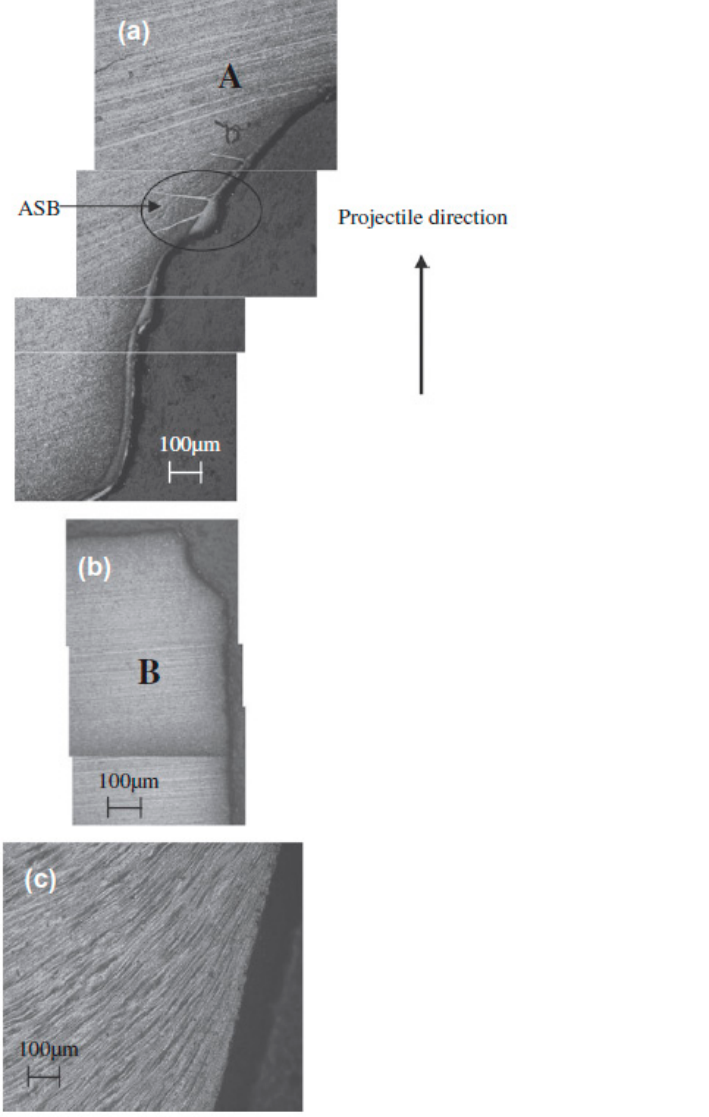
Figure 13. Micrograph of through thickness region of (PHHS + Al-alloy; PHHS-Perforated High Hardness Steel) configuration having 6 mm square holes ( a ) side A of front PHHS plate, ( b ) side B of front PHHS plate and ( c ) backing Al-alloy plate. The arrow shows the direction of the projectile. [47]. Reprinted with permission from Elsevier: Mater. Des. , Copyright 2021, License: 5017591074019.